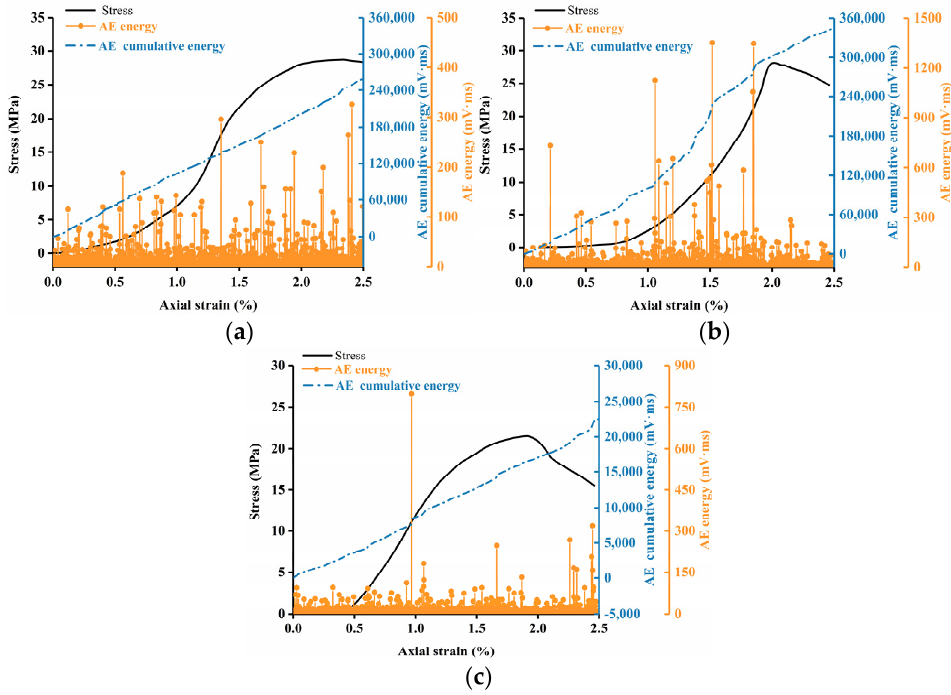
Figure 8. Characteristics of AE energy-time evolution. ( a ) SRB-1. ( b ) SRG-1. ( c ) SRL-1.